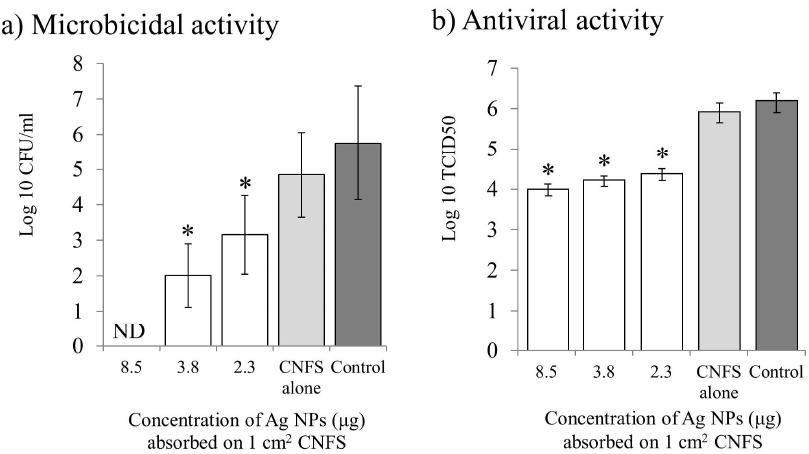
Figure 4. The microbicidal / antiviral activity of materials using Ag NPs / CNFS with various concentration of Ag NPs [48]. The activities of various concentrations of Ag NPs on CNFS against E. coli ( a ) and H1N1 Influenza A ( b ). Data are mean value ± standard deviation ( n = 6); the asterisk indicates a statistically significant di ff erence ( p < 0.01) using two-sample t-test vs. control. ND means non-detection. The vertical axis is listed with a common logarithm. For example, with an Ag NP concentration of 8.5 µ g / cm 2 in the CNFS in ( b ), there was a reduction of greater than 2 log10 (100-fold) corresponding to a reduction of viral titers by approximately 99%.